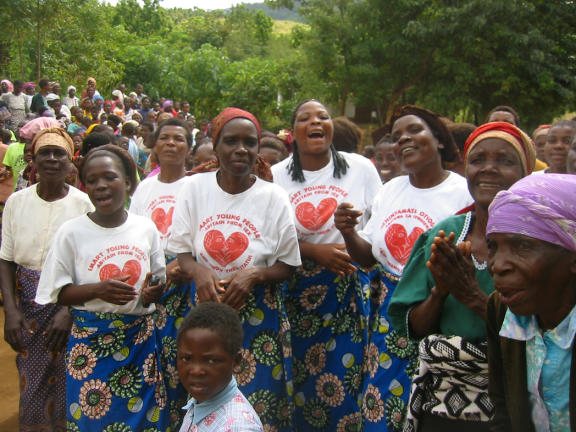
Village CaregiversThis photograph shows some of the local women who work with Global AIDS Interfaith Alliance village-level projects in Africa, funded by the Bill and Melinda Gates Foundation. These women teach people about HIV/AIDS, help care for orphaned children, and visit and care for each person ill with AIDS every day. In doing so, they have helped to break down stigma in their villages.(Photo: Global AIDS Interfaith Alliance)